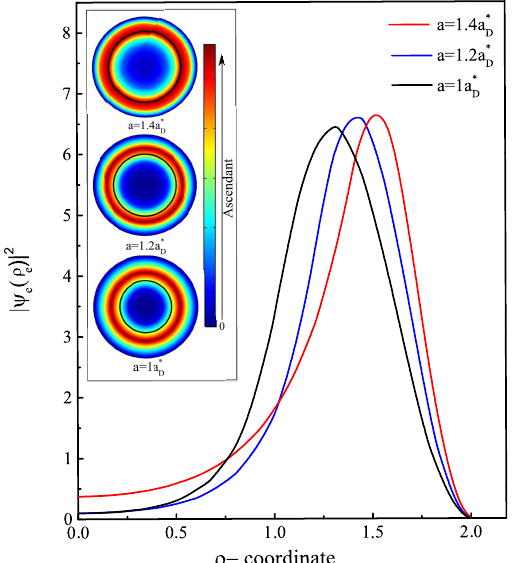
Figure 3. Electron probability density in Al x Ga 1 − x As/GaAs core/shell NW along the radial direction ρ at zero magnetic field ( γ = 0). Three core radius values are considered a = 1,1.2 and 1.4 a ∗ than the threshold radius a 0 . Each linear representation corresponds to the planar representation, which is the xy-plane cross-section of the electron density distribution at the middle of the